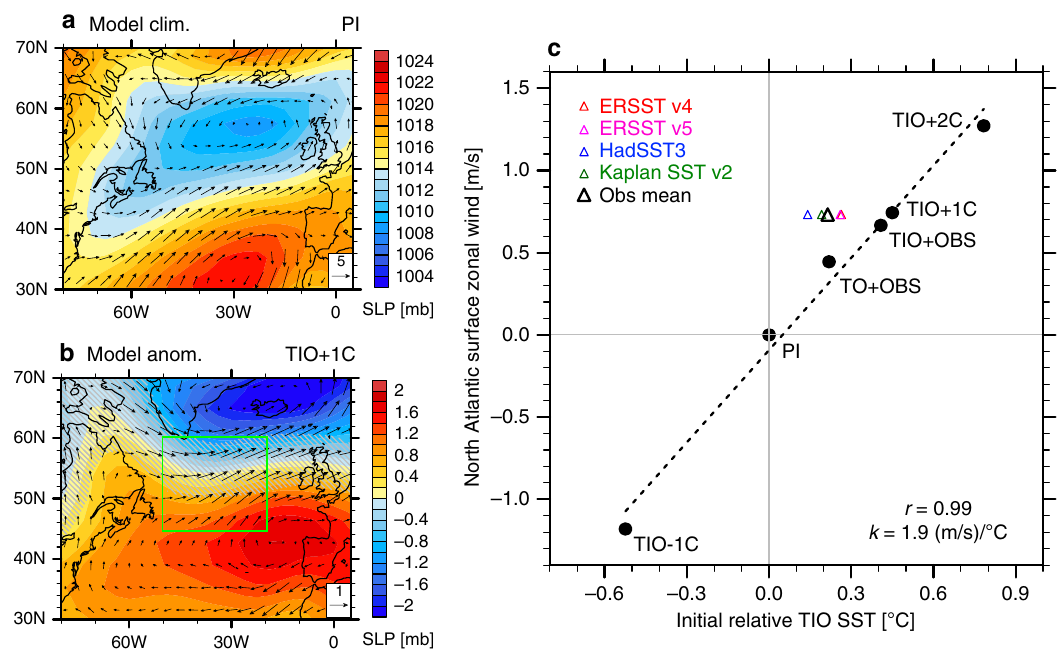
Fig. 5 The North Atlantic surface wind response to tropical Indian Ocean (TIO) warming. a 40-year pre-industrial (PI) climatological mean and ( b ) anomalies in the TIO + 1C experiment during Years 1 – 40 for sea level pressure (SLP; units: mb) and surface wind vectors (units: m s − 1 ). Gray hatches highlight the areas of lower statistical signi fi cance ( p -values of Student ’ s t test above 0.05). c Anomalies in surface zonal wind averaged within the green box shown in panel (b) in different simulations versus anomalies in the relative TIO sea surface temperature (SST). Anomalies are with respect to the pre- industrial (PI) experiment. The relative TIO SST is de fi ned as average SST in the Indian Ocean (30°S – 30°N, 40°E – 100°E) minus the whole tropical ocean (30°S – 30°N) value; “ initial ” means averaged during Years 1 – 40. Colored triangles indicate the observed changes during 1950 – 2015 (long-term trends multiplied by 66 years) for NCEP/NCAR Reanalysis winds and different SST datasets; the black triangle represents their averages. The dashed lines are linear regression curves with the correlation coef fi cient ( r ) and the regression slopes ( k ) also shown.